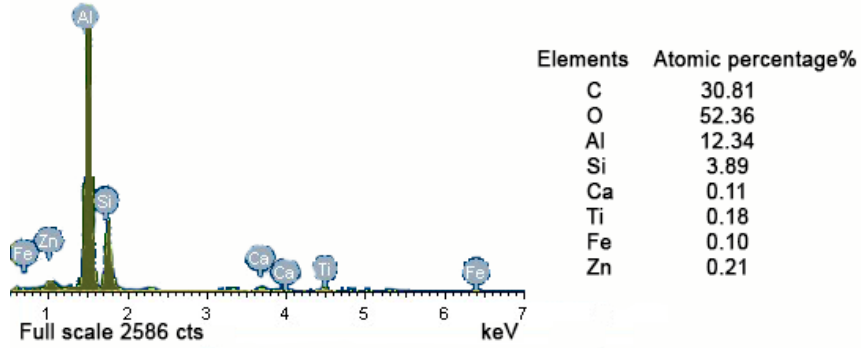
Figure 3. Fracture defect energy spectrum of specimen No. 1.